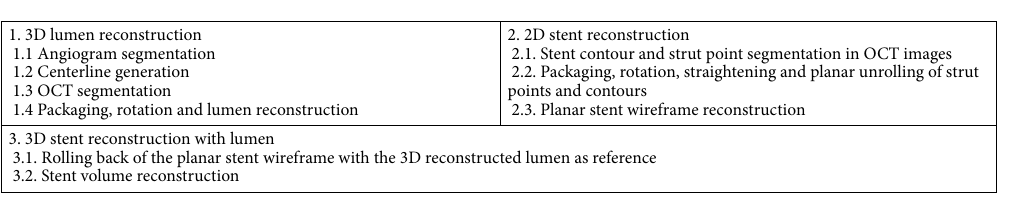
Table 2. Steps of the proposed method for 3D stent